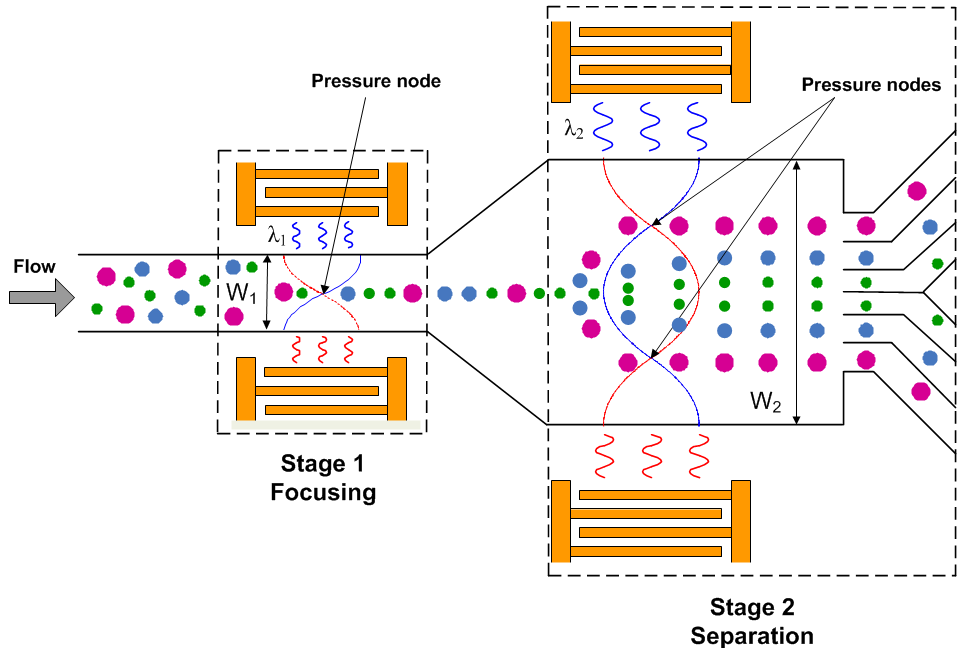
Figure 1. Conceptual view of the sheathless particle separator using standing surface acoustic waves. The first stage aligns the particles on the center line, while the second stage separates them according to